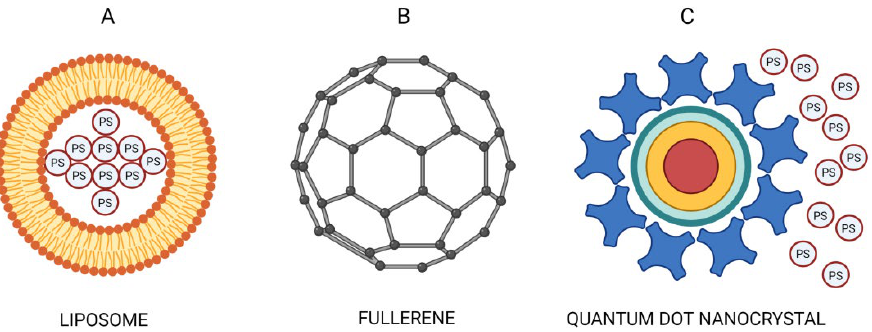
Figure 1. ( A ) Liposomes as a representative of the first class of NPs—carriers of PSs. ( B ) Fullerene as a representative of the second class of NPs—PSs by themselves and ( C ) Quantum dot nanocrystal as a representative of the third class of NPs—energy transducers of PSs.